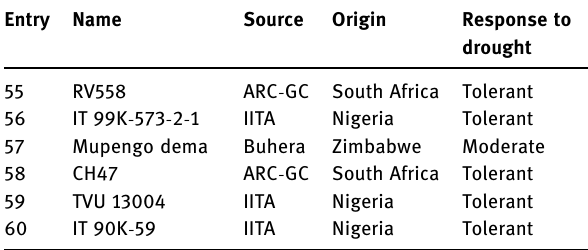
Table 6: The response to drought stress of 60 - cowpea accessions based on 14 traits